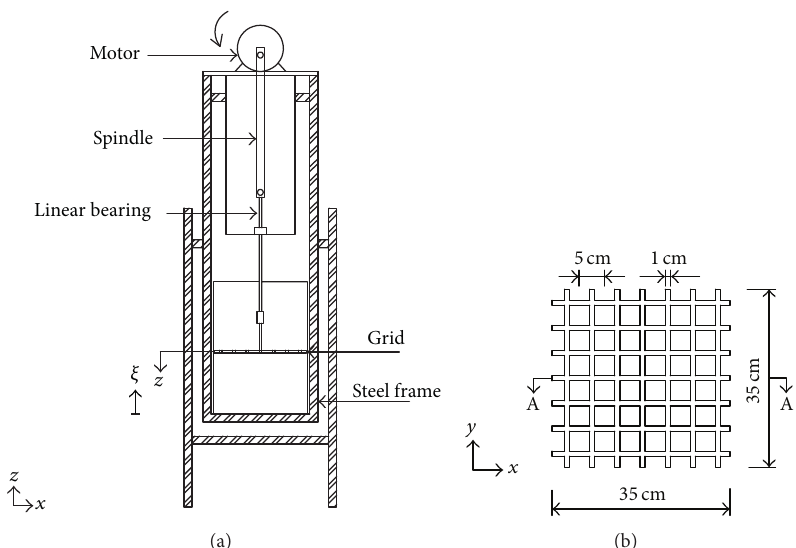
Figure 1: Sketches showing (a) the experimental setup and (b) a (magnified) plan view of the uniform grid. A sediment bed is placed at the bottom of the tank. The symbol 𝜉 denotes the distance from sediment bed, where 𝜉 = 0 is the tank